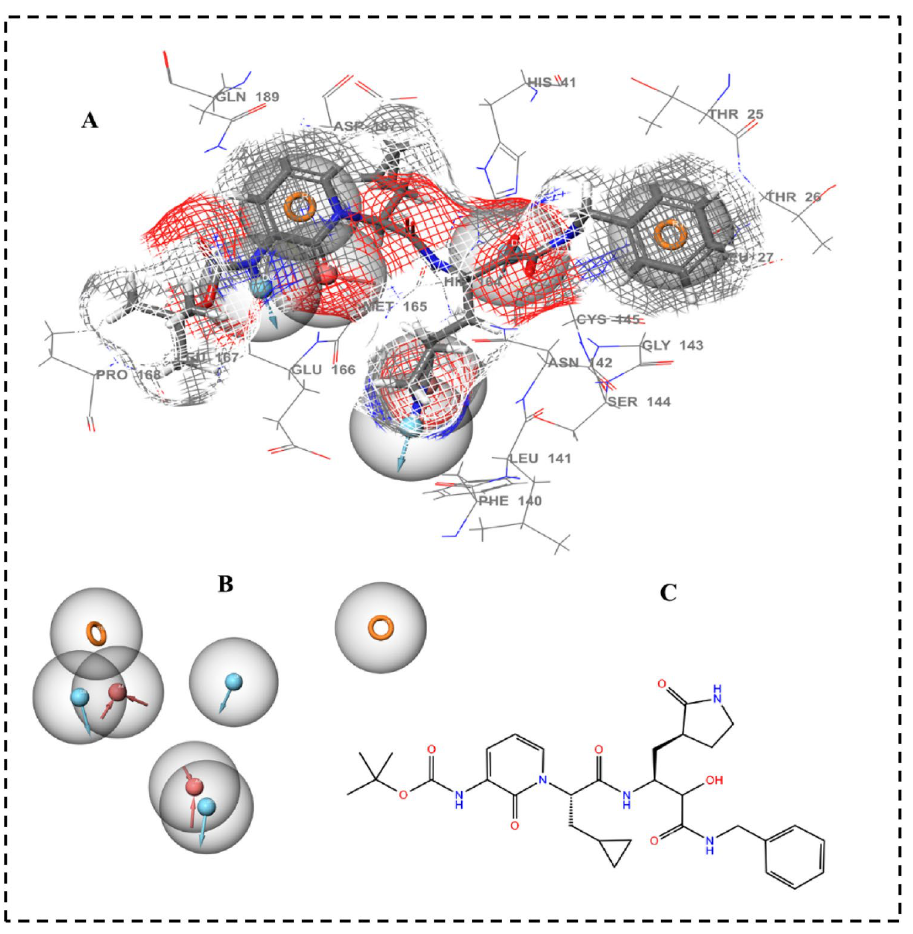
Figure 2. ( A ) 3D structure-based pharmacophore features of αk-13b inhibitor in the complex interacting with M pro binding site. ( B ) The seven generated pharmacophore features in Red arrow: Hydrogen bond acceptor, blue arrows: Hydrogen bond donor, orange: aromatic ring. ( C ) 2D chemical structure of the